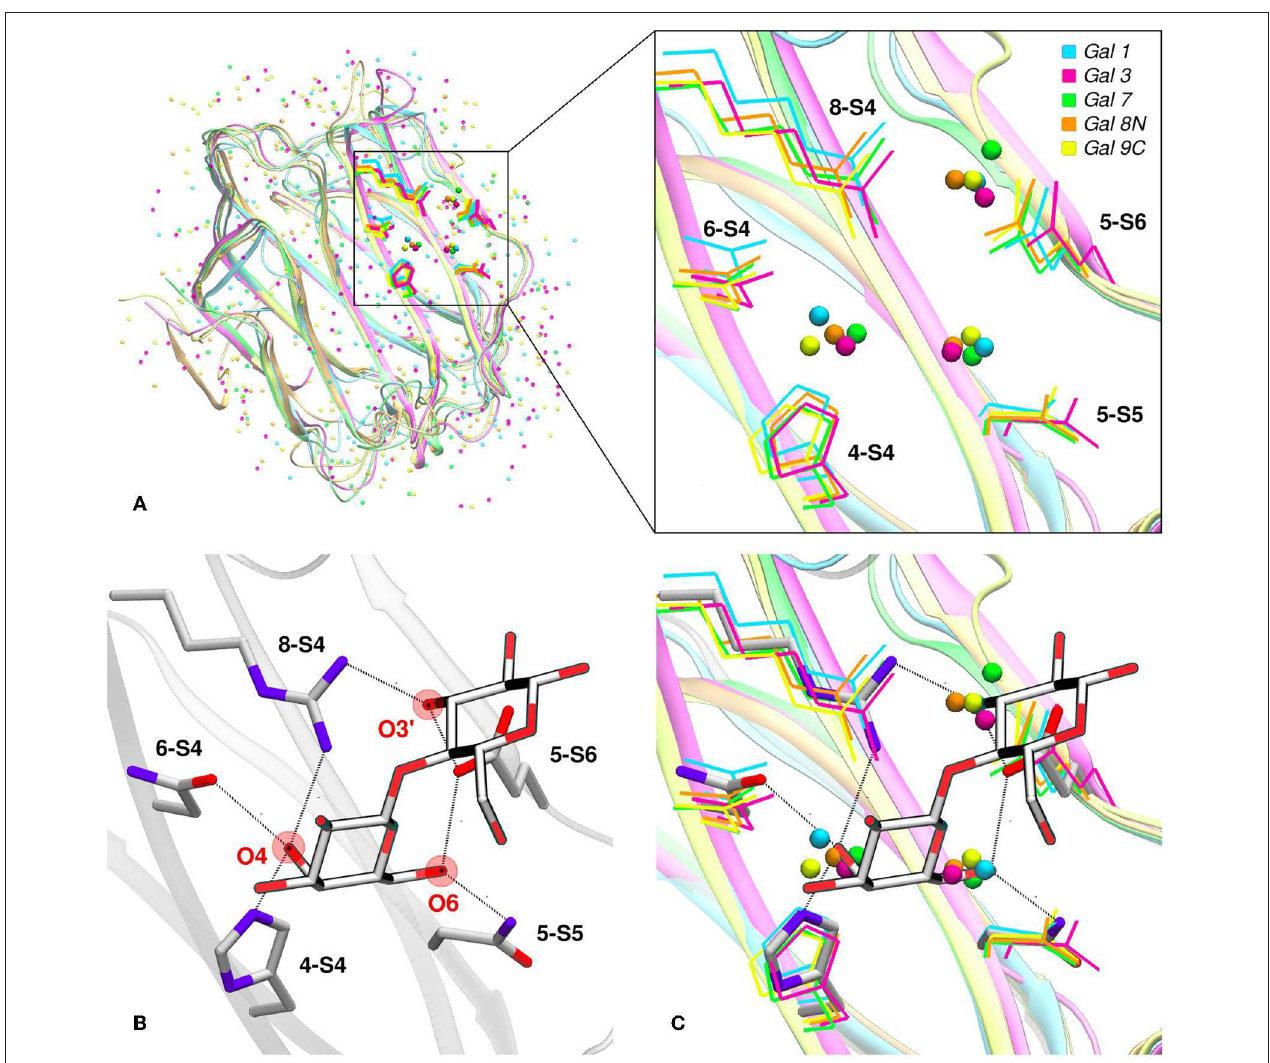
FIGURE 4 | Solvent structure of several human galectins. (A) Apo X-rays superimposition showing highly ordered crystallographic water molecules in the CBS. Color code is cyan for Gal-1 (1w6n-B), magenta for Gal-3 (3zsm-A), green for Gal-7 (4gal-A), orange for Gal-8N (3apb-B), and yellow for Gal-9C (3nv1-A). (B) Detail of Gal-1 (1w6o-A) in complex with lactose, showing the main polar residues and the Hydrogen bond network (dotted lines) established with the ligand. (C) Superimposition of A and B, showing that a clear displacement of water molecules is needed for binding to proceed.